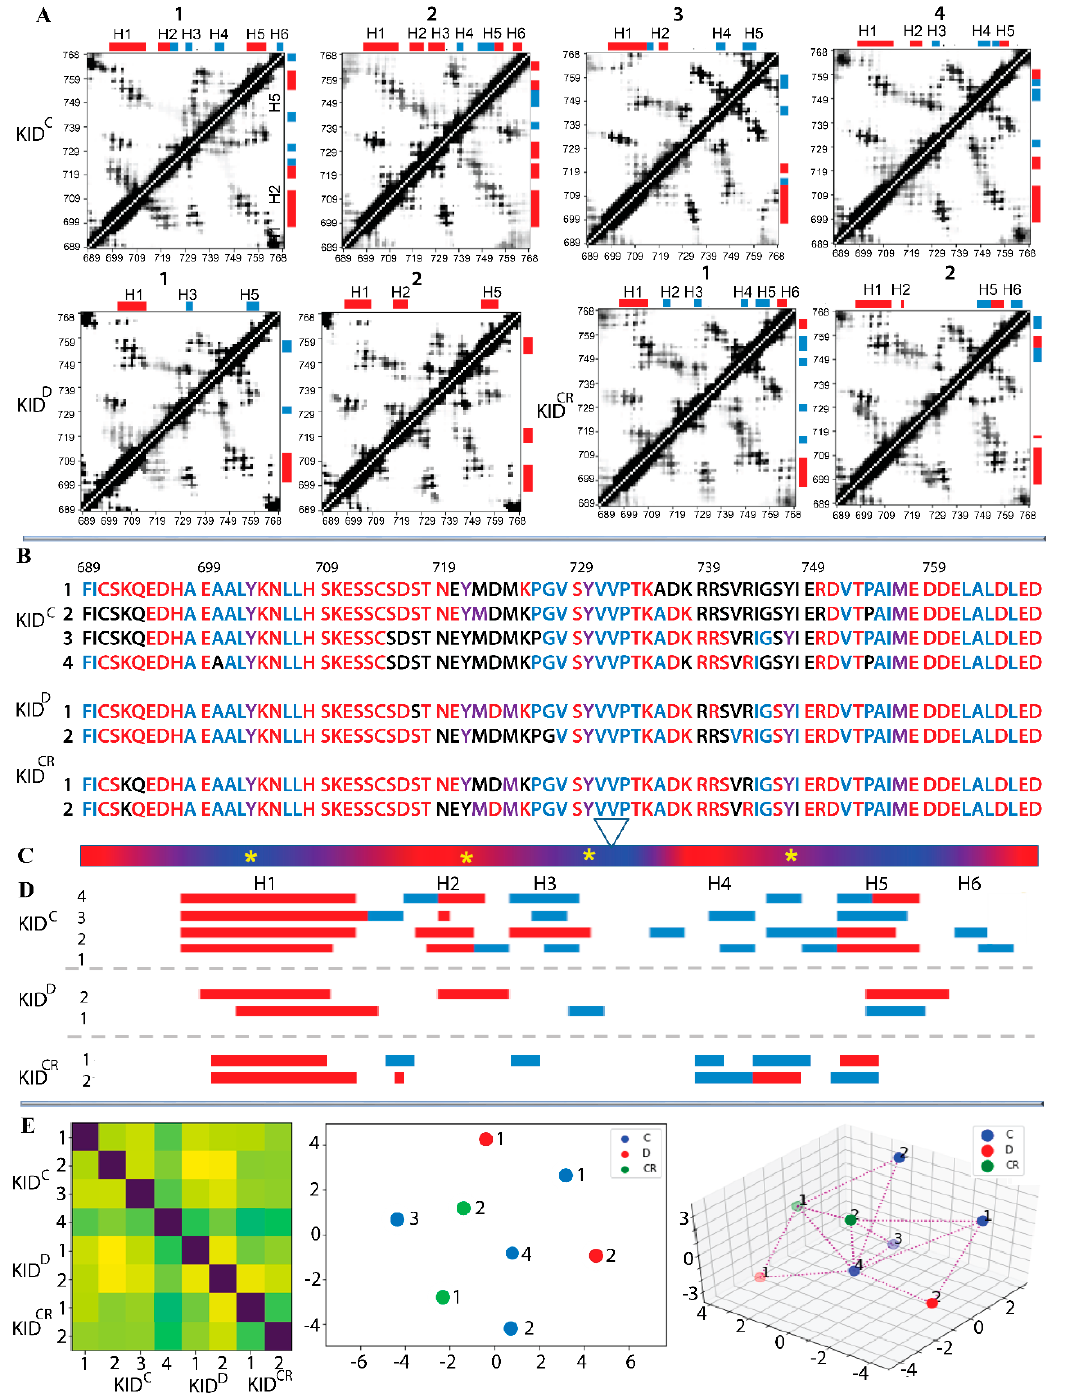
Figure 3. Estimation of intramolecular contacts in KID. ( A ) Dynamic contact maps of pairwise distances C α − C α < 10 Å computed for each MD trajectory. Black–white gradient shows a frequency (from 1 to 0) of contact during a trajectory. Secondary structure bars are shown at the top and on the left of the contact map. ( B ) Residues participating in steady contacts (in colour) were identified from ( A ) and analysed visually (PyMOL). Residues from the ‘pseudo-rigid’ segments E699–S709, P754–L764 and V731–P733 were used as an origin for the computing of contacts to all residues of KID. Only the contacts with an occurrence greater than 80% were considered. Polar, hydrophobic, and amphiphilic residues are denoted in red, blue and violet respectively. ( C ) Red–blue gradient shows the RMSF values, from large (>4 Å, in red) to small (<2 Å, in blue). The position of tyrosine residues is shown by the yellow asterisks. ( A , D ) The α H- (red) and 3 10 -helices (blue), were assigned by DSSP on average conformation from each MD trajectory and labelled from H1 to H6. ( E ) The per-residue